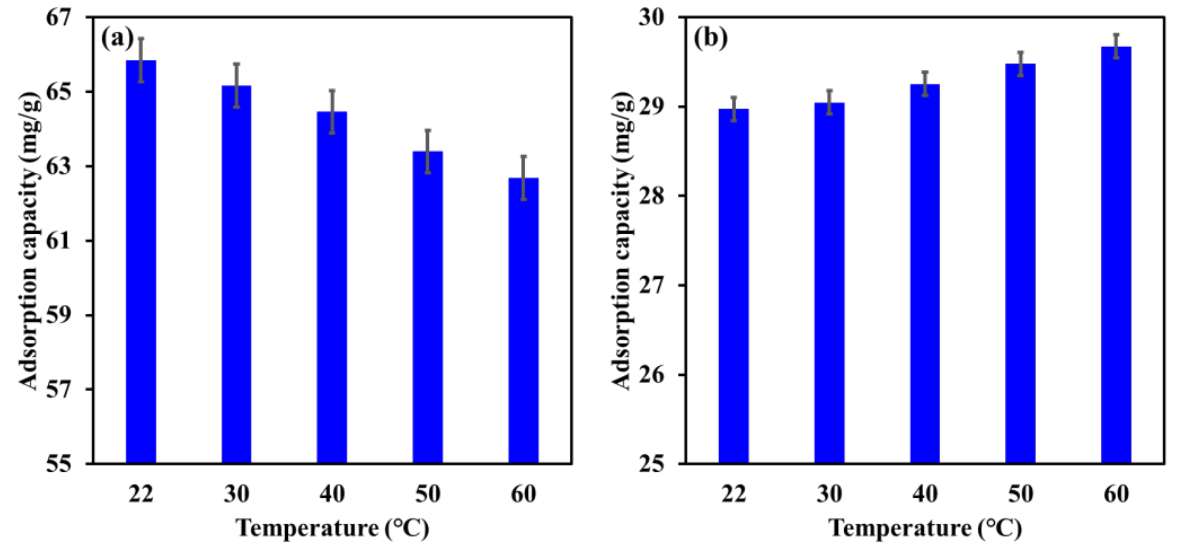
Figure 11. Influence of temperature on the adsorption capacity of Mg-Ca-Al-LDO composite for EBT ( a ) and Cr ( b ) ions. [EBT] i = 50 mg/L; [Cr] i = 30 mg/L; contact time, 24 h; dosage, EBT 0.75 g/L, Cr 1.25 g/L; [pH] I , EBT 5.2, Cr 6.